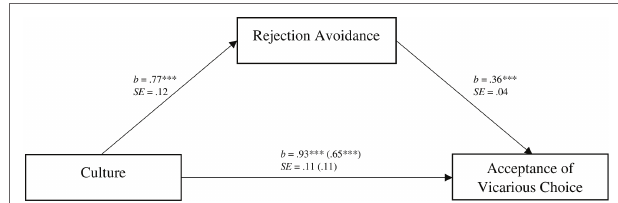
FIGURE 3 | Individual levels of rejection avoidance as a mediator of the cultural differences in acceptance of vicarious choice in Study 2. Unstandardized coefficients and standard errors are shown. Coefficients indicating the relationship between culture (coded as German culture = 0 and Japanese culture = 1) and acceptance of vicarious choice after controlling for rejection avoidance tendencies are given in parentheses. *** p <